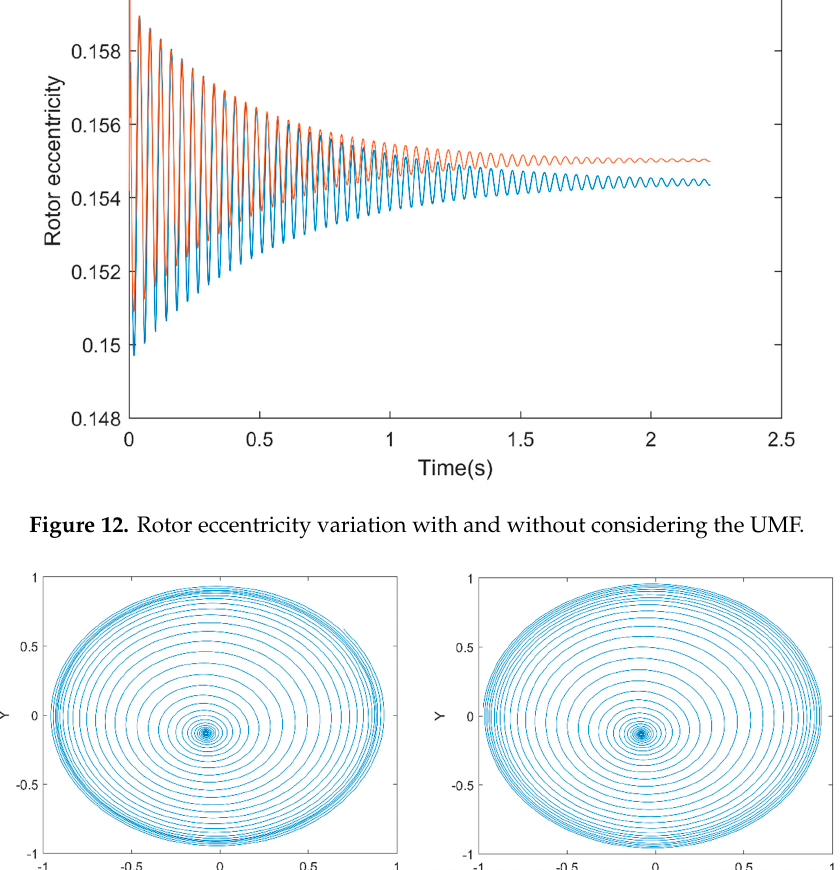
Figure 11. Rotor center trajectory at 𝐹 (cid:3032) = 0.0987,𝑀 = 0.1071 . ( a ) Without considering the UMF; ( b ) with considering the UMF.